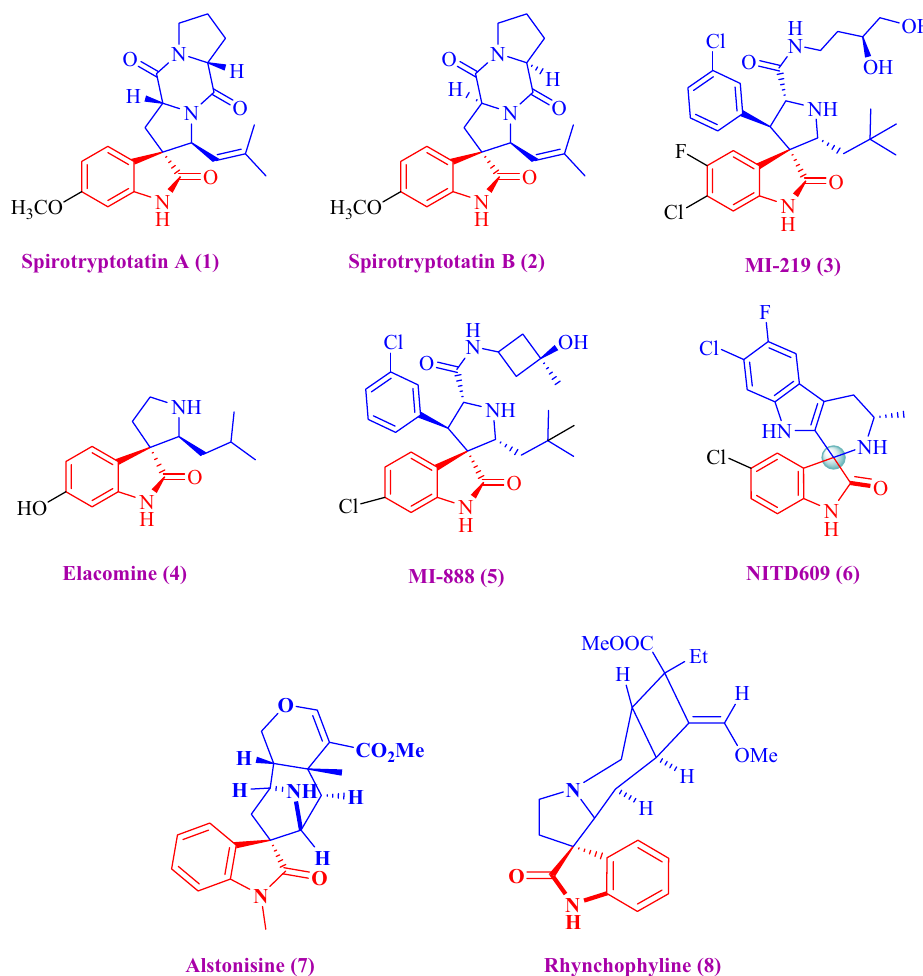
Figure 1. Spirooxindoles compound exhibiting biological